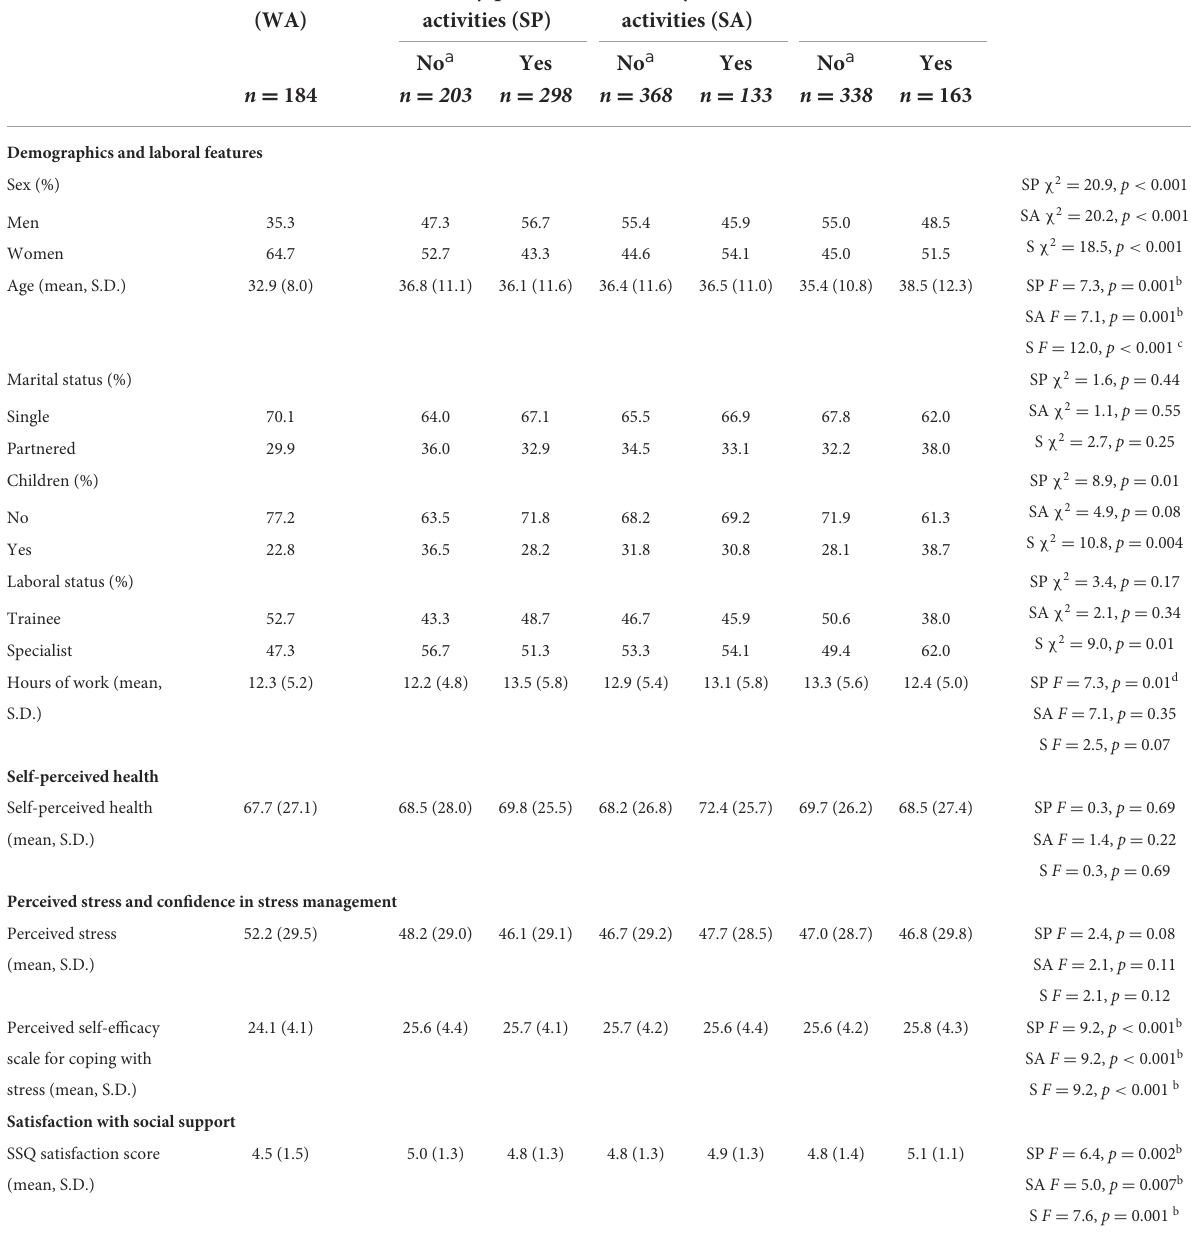
TABLE 1 Bivariate comparisons of demographics, work-related features, self-perceived health, perceived stress, confidence in stress management, and satisfaction with social support according to leisure activity type. Variables Without activities Solitary-passive Solitary-active Social activities (S) (WA) activities (SP) activities (SA)